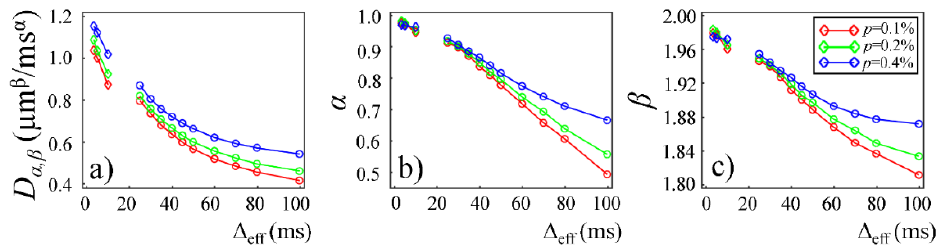
Figure 9. Plots of D α , β ( a ), α ( b ), and β ( c ) versus ∆ eff obtained from the Monte Carlo simulations with fixed r = 8 µm and varying p of 0.1% (red), 0.2% (green) and 0.4% (blue). The rhombi and circles represent the simulation results with oscillating diffusion gradient (OGSE) and Stejskal – Tanner diffusion gradient (PGSE/PGSTE), respectively.